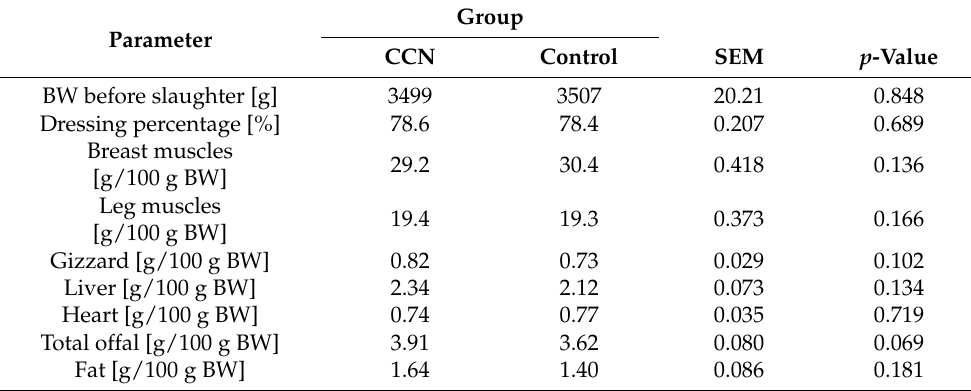
Table 3. Results of male broiler chickens slaughter analysis.